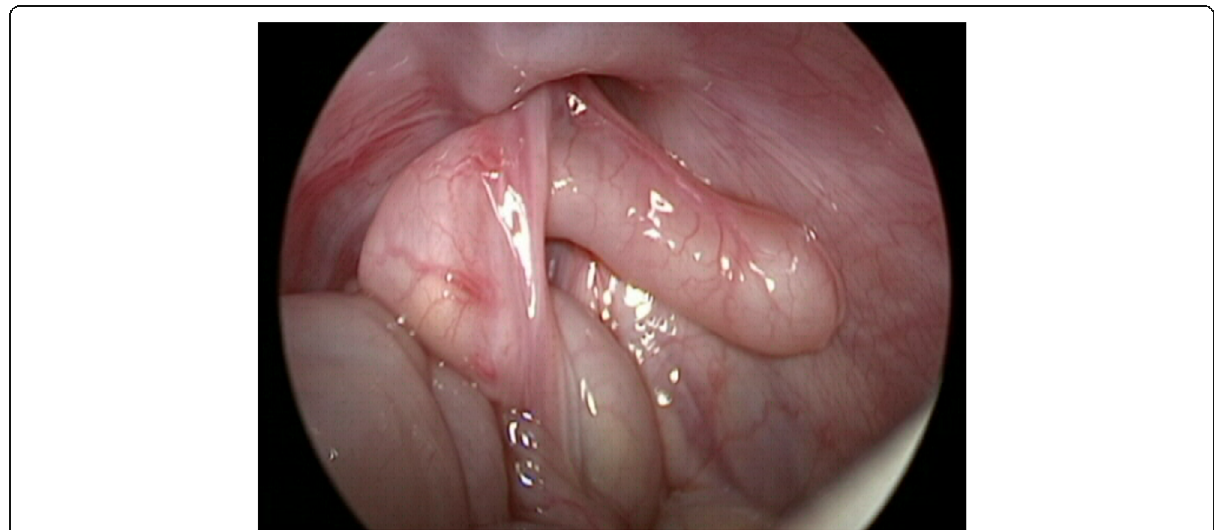
Fig. 4 Laparoscopic view of AH after reduction of the